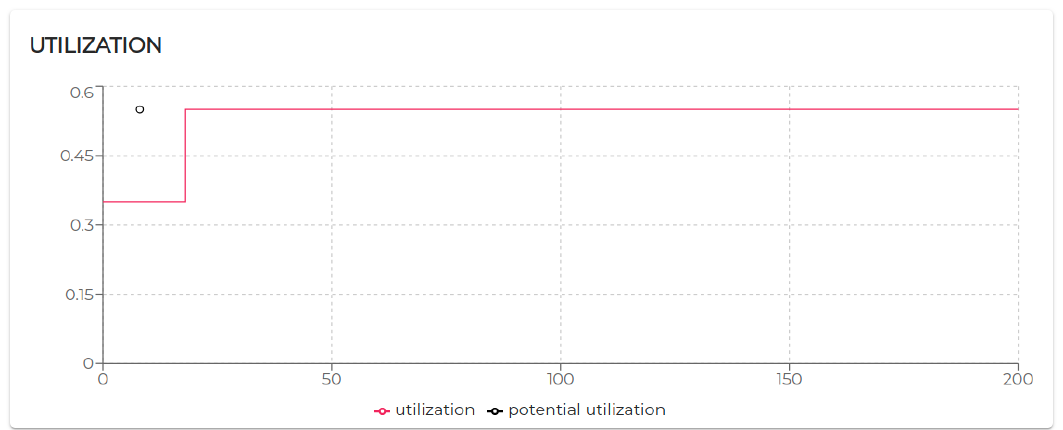
Figure 9. Agens utilization over the simulated time [0–200 s] in scenario S1. y-axis: utilization (adimensional); x-axis: time (seconds).